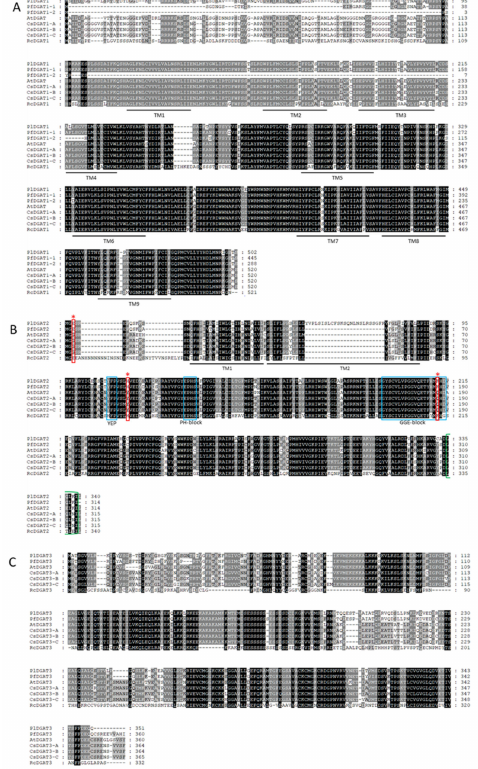
Figure 10. DGAT protein sequences alignment. Amino acid alignment of DGAT1 ( A ), DGAT2 ( B ), and DGAT3 ( C ). Putative transmembrane domains are underlined. The red asterisks and boxes indicate the amino acid corresponding to the 3rd, 115th, and 212th of PlDGAT2. The conserved YFP motif [108], PH-block and GGE-block [98] in plant DGAT2s are indicated in blue boxes. The modestly conserved ER retrieval motif in plant DGAT2s is in green brackets [103]. Abbreviation: Pl, Physaria lindheimeri ; Pf, Physaria fendleri ; At, Arabidopsis thaliana ; Cs, Camelina sativa ; Rc, Ricinus communis . Genbank accession numbers were listed in Supplementary File 6, Tables